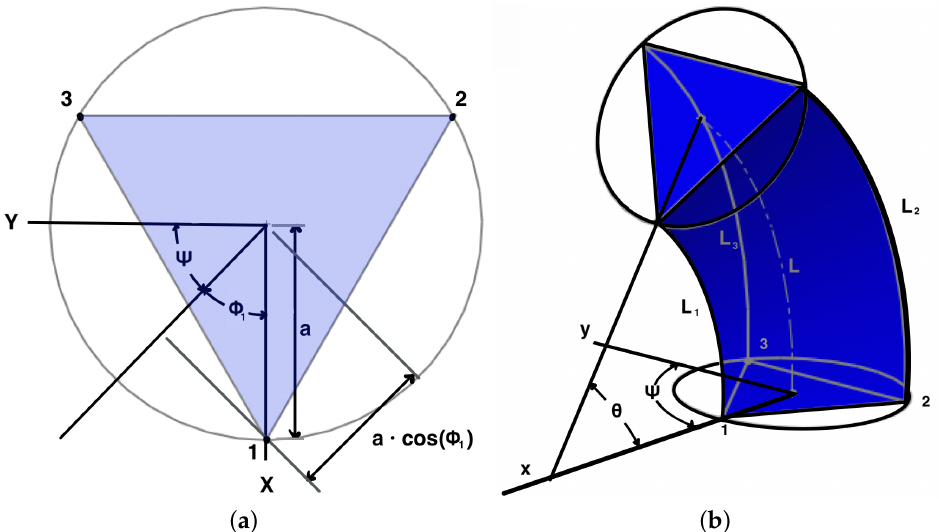
Figure 10. ( a ) Base projection of the soft joint, ψ = 45 ◦ , for the representation of orientation, distances and numbering of tendons. ( b ) Three-dimensional representation of the joint with θ = 45 ◦ orientation and ψ = 90 ◦ inclination. Note the different curvatures for the soft joint and for each tendon L i